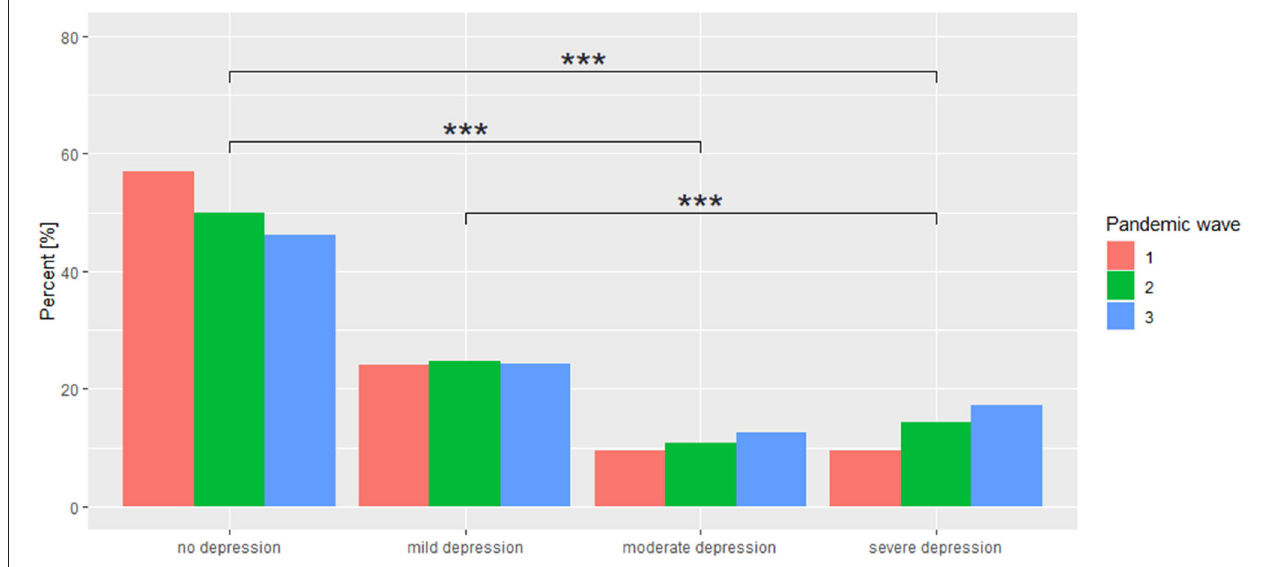
FIGURE 1 | Distribution of BDI interpretations across individual COVID-19 pandemic waves. *** p < 0.001.